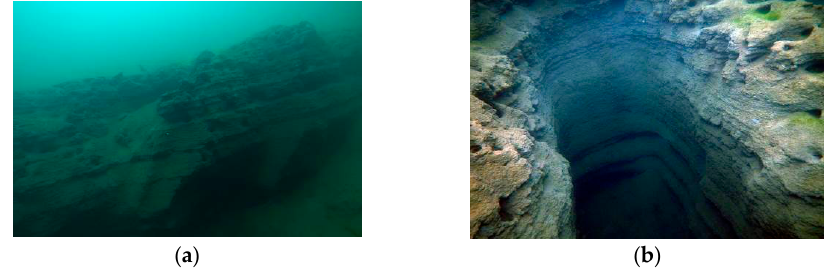
Figure 8. Underwater surveys from 2016 in Lago Tramonto, Gambulaga, Portomaggiore (FE, Italy: ( a ) Clay banks cut by the dredge; ( b ) A vertical hole caused by the fixing pile of the dredge (photo by Giovanna Bucci).